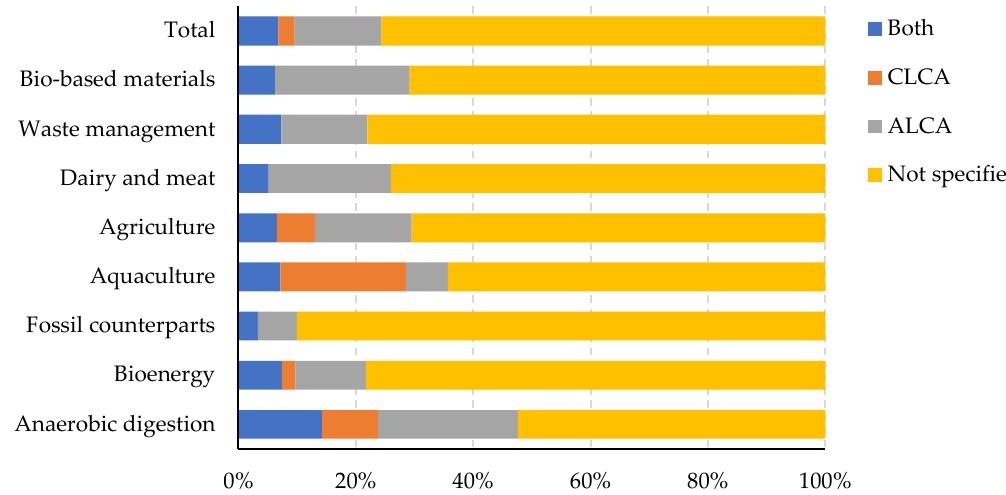
Figure 3. Percentage of articles which applied on the same case study both CLCA and ALCA approaches (Both), self-declared attributional studies (ALCA), self-declared consequential studies (CLCA) and studies which did not declare the approach followed (Not specified). Only case studies published after 2004 were considered (504).